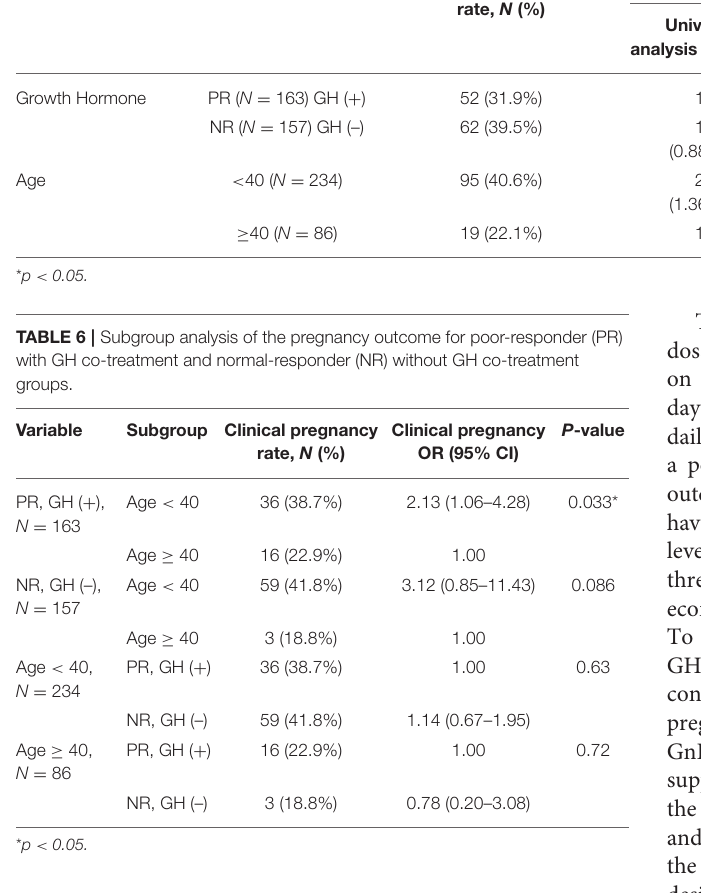
TABLE 5 | Logistic regression with univariate and multivariate analysis of pregnancy outcome for poor-responder (PR) with GH co-treatment and normal-responder (NR) without GH co-treatment groups. Variable